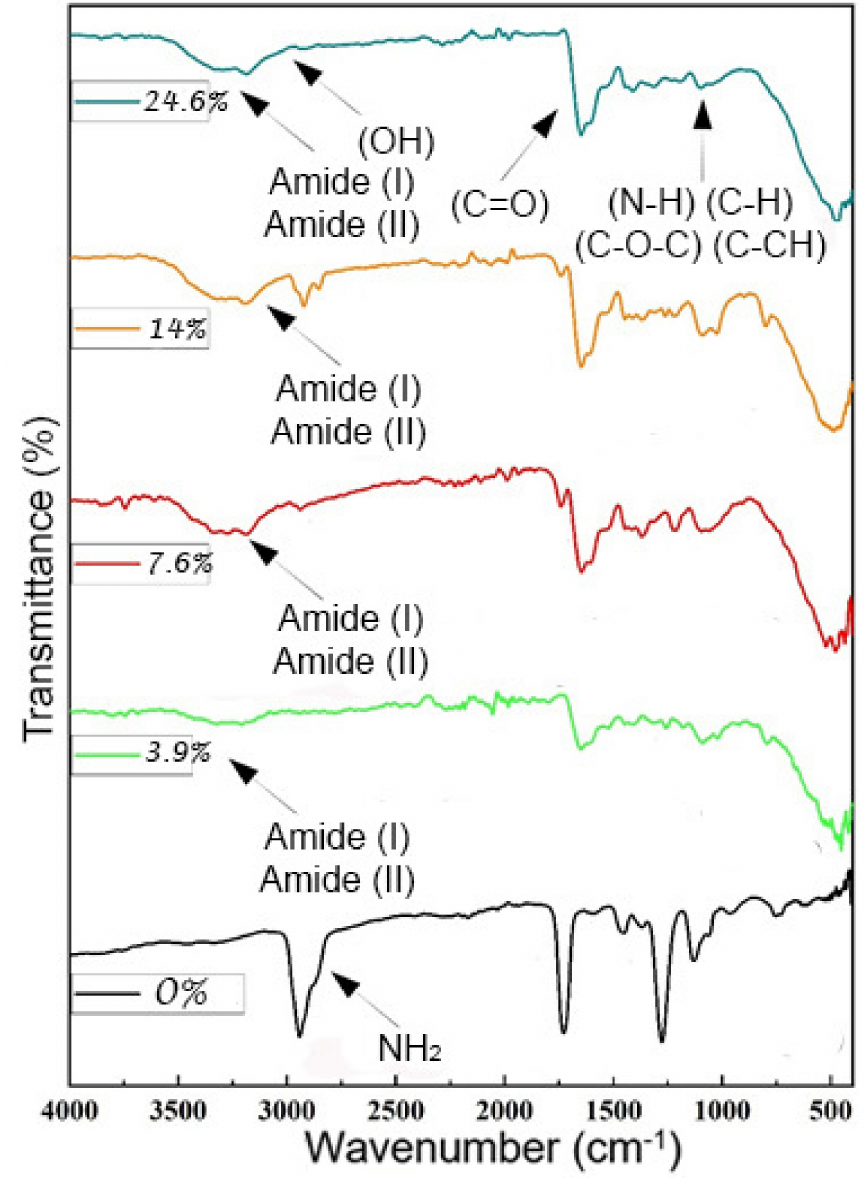
Figure 4. FTIR spectra of PAAM/chitosan xerogels containing different amounts of